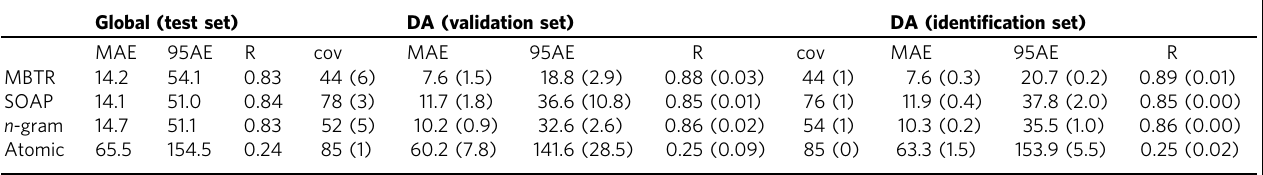
Table 2 Summary statistics for DAs for all investigated models. Global (test